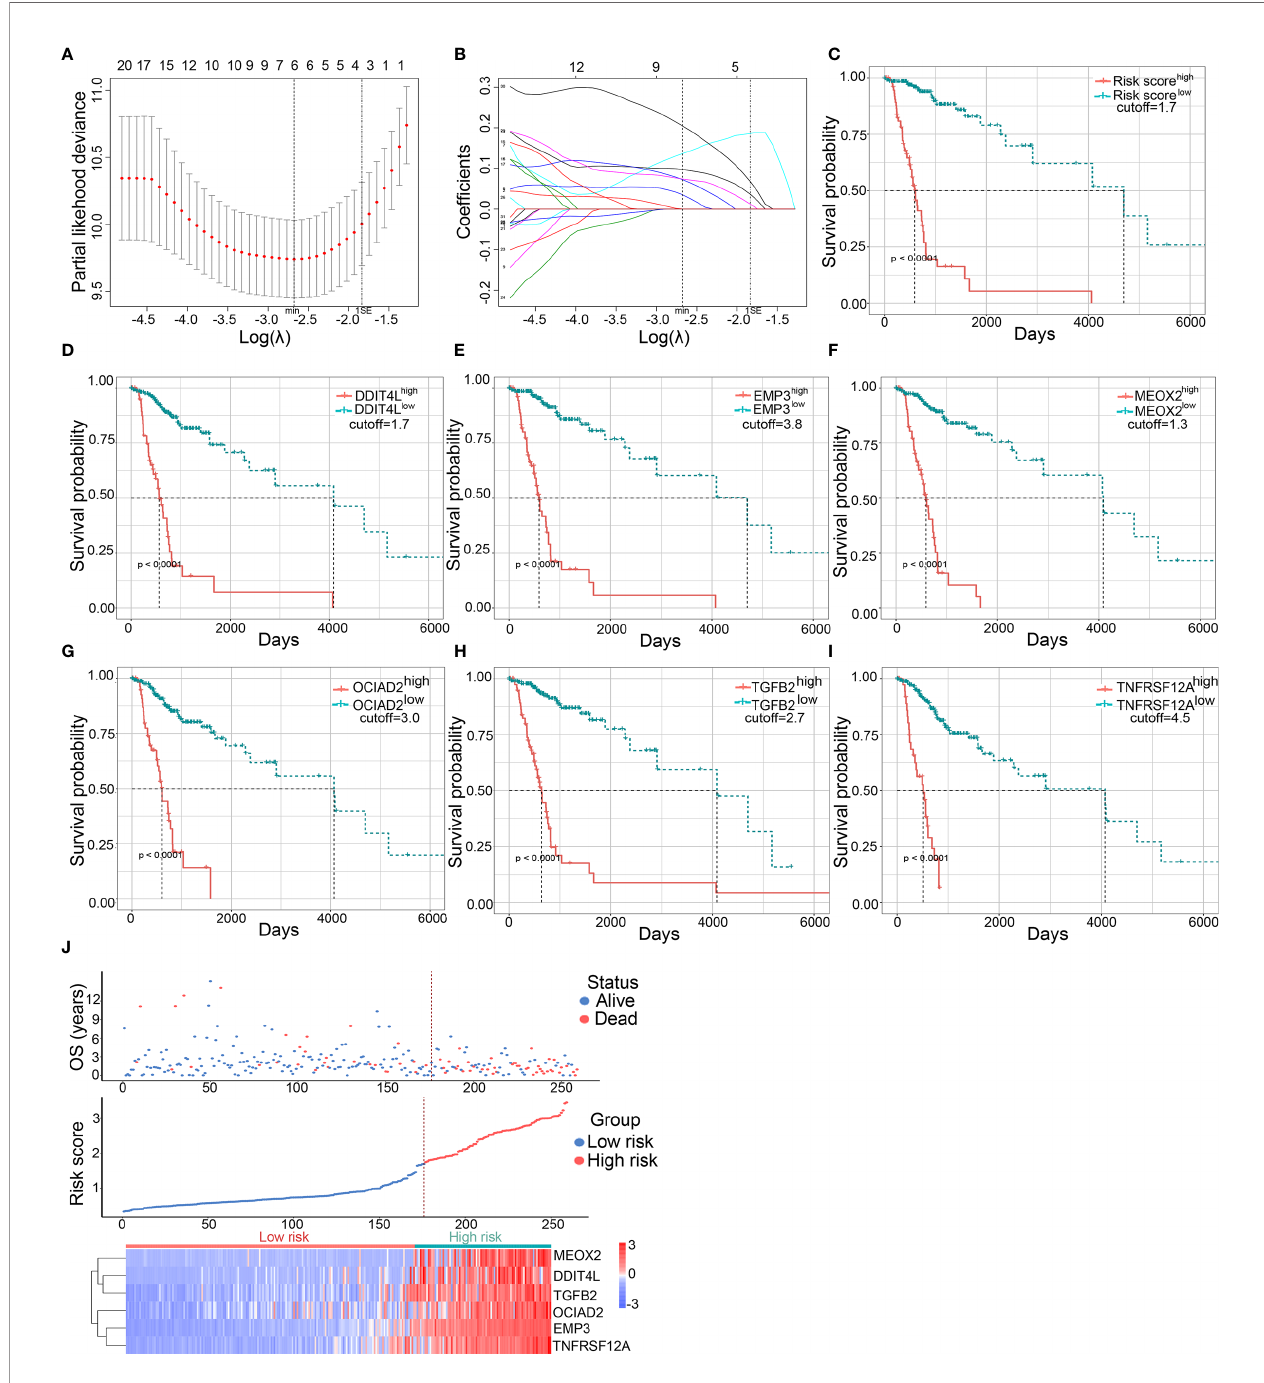
FIGURE 3 | Establishment and validation of the predictive transcriptional risk score in TCGA dataset. (A) The risk gene cluster was selected by LASSO Cox regression with 10-fold cross-validation for tuning parameter ( l ) selection in TCGA cohort, in which the vertical dashed lines showed minimum l value and 1× standard error l value, respectively. (B) The LASSO coef fi cient pro fi le of all candidate genes in TCGA cohort, in which the vertical dashed lines showed minimum l value and 1× standard error l value, respectively. (C – I) The Kaplan – Meier survival curves were performed in transcriptional risk score, DDIT4L expression, EMP3 expression, MEOX2 expression, OCIAD2 expression, TGFB2 expression, and TNFRSF12A expression in TCGA dataset; the optimal cutoff value was derived from X-tile (all p < 0.0001, with log-rank test). (J) The risk factor association diagram in TCGA cohort. The results showed the blue dots in the fi gure representing the surviving LGG patients and the red dots representing death, and the corresponding risk gene cluster mRNA expression pro fi les were visualized as a heatmap. The dotted line indicated the optimal cutoff value of the mRNA risk score, in which all LGG patients were divided into two groups including 176 low transcriptional risk score samples and 83 high transcriptional risk score